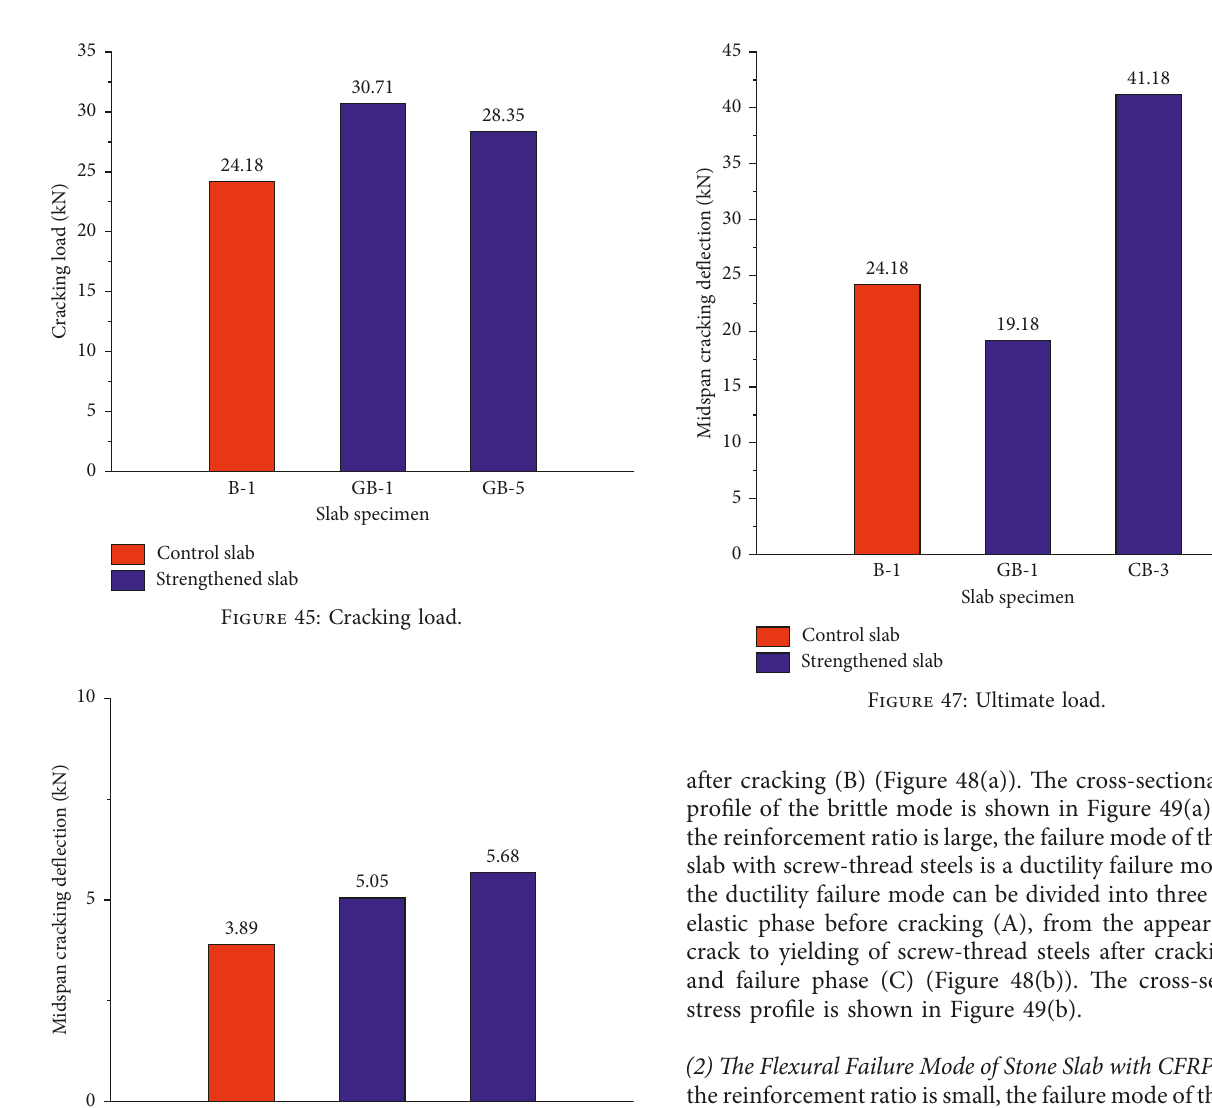
Figure 47: Ultimate